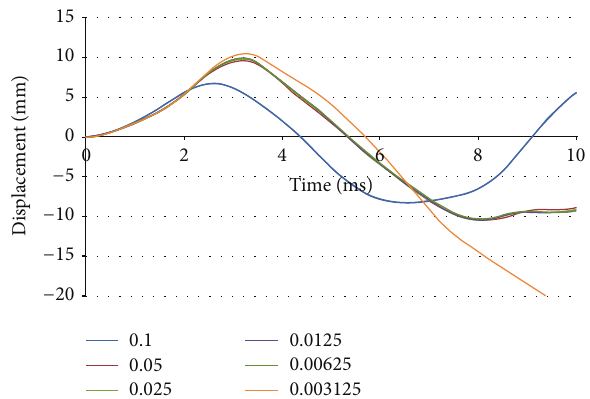
Figure 10: Displacement history for different mesh sizes, for a blast- loaded laminated glass, boundary condition according ISO